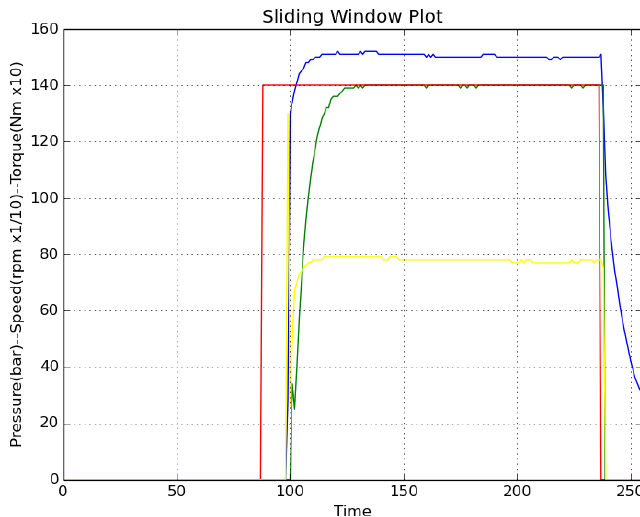
Figure 13. Pump running at 1400 rpm.